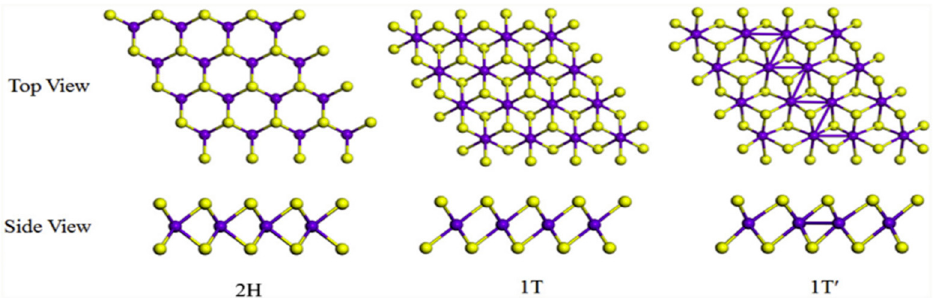
Figure 3. Top and side-view of MoS 2 monolayer crystalline phases [30]. Reprinted with permission from [30]. Copyright 2018. Elsevier.